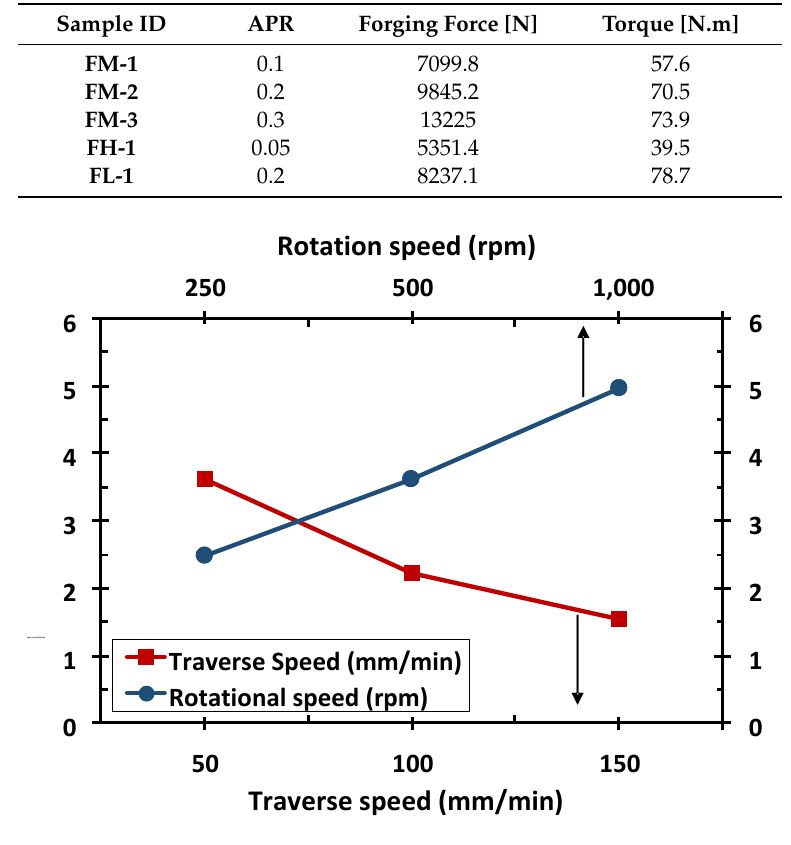
Figure 2. Variation of the heat input as a function of the rotation and traverse speeds.